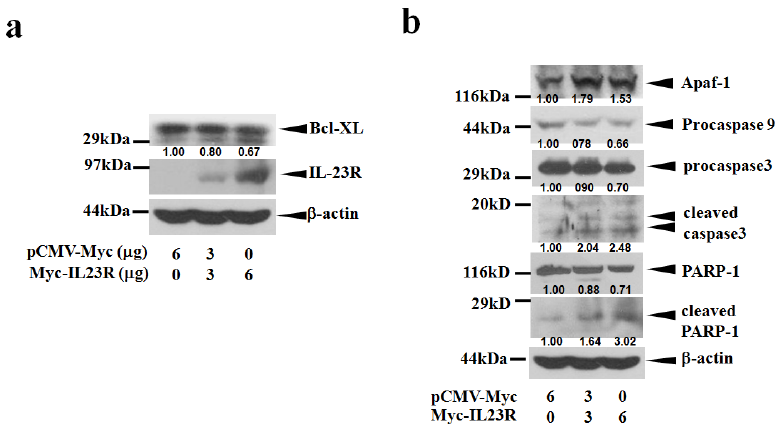
Figure 4. IL-23R mediated cell apoptosis in 293ET cells is associated with mitochrondia mediated intrinsic pathway. ( a ) IL-23R inhibited Bcl-xL expression in a dose dependent manner; and ( b ) The cell lysates prepared from IL-23R transfected 293ET cells after 48 h transfection were probed with anti-caspase 3, anti Apaf-1, anti caspase 9 and anti-PARP-1 antibodies and analyzed by Western blot analysis. Beta-actin gene expression was served as internal control. In both ( a ) and ( b ), the relative intensity of individual band was calculated based on the expression of β -actin by using the Quantity One program.